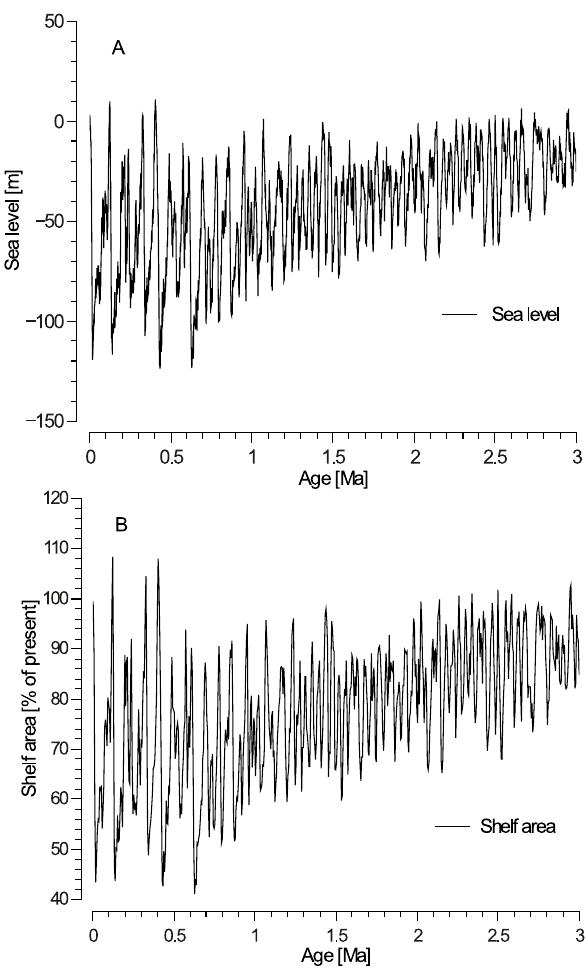
Figure 1. Sea level and shelf area estimate. (a) Sea level estimate (Miller et al., 2011). (b) Calculated shelf area using polynomial fit (Bjerrum et al., 2006) of ETOPO-5 global mean hypsometric curve.